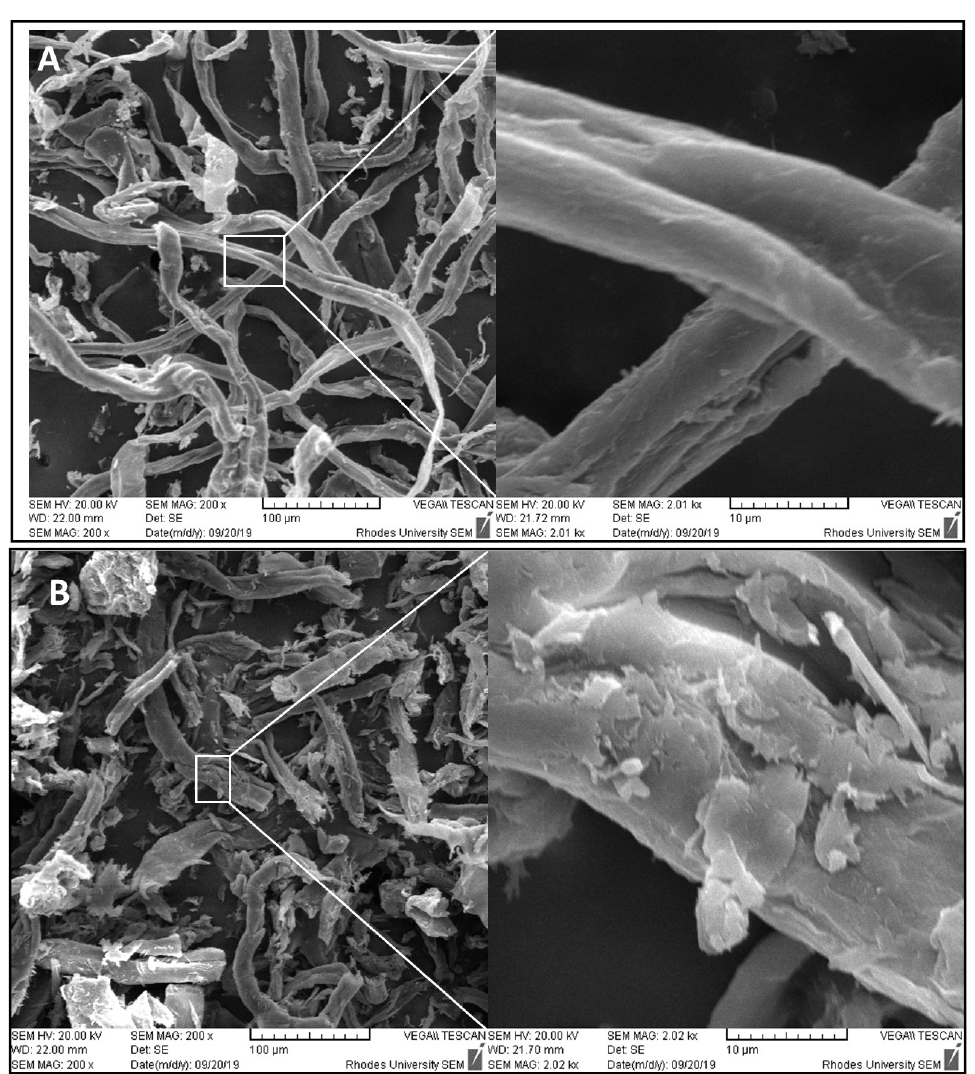
Figure 5. Scanning electron microscopic (SEM) analysis of paper sludge: surface morphology of ( A ) paper sludge before enzyme treatment and ( B ) solid residues after enzymatic hydrolysis by the Opt CelMix at a protein loading of 7.5 mg/g biomass. Two magnifications for each sample were used; 200 × magnification allows the observer to see fibril length reduction while 2000 × magnification allows the observer to see fibril surface erosion upon enzyme hydrolysis.